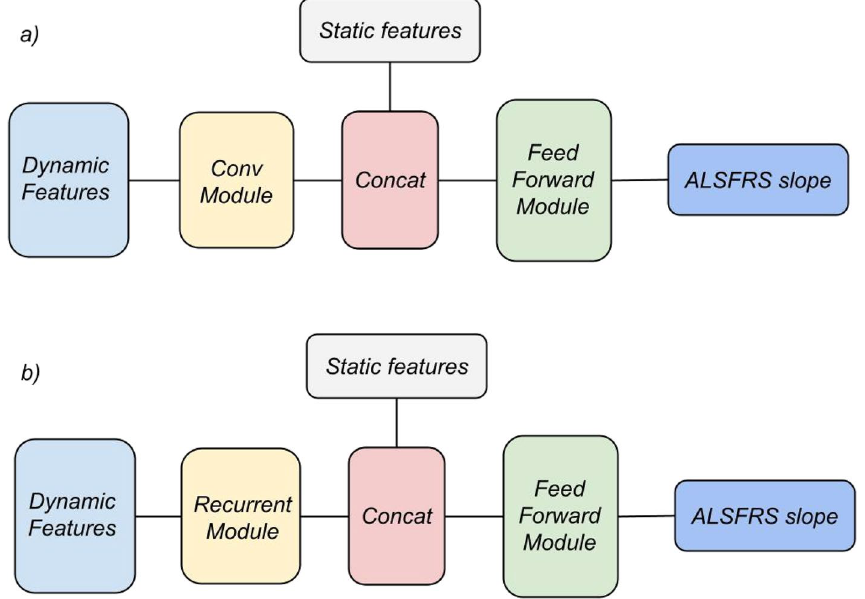
Figure 1. ( a ) Convolutional neural network architecture. The dynamic features of the questionnaire dataset flows into the convolutional module constituted by two layers; after the concatenation with the static features, the information is fed into a feed-forward neural network to predict the two outcomes. ( b ) Recurrent Neural Network architecture. The structure is the same as the convolutional architecture except for the Recurrent module that processes the dynamic features.